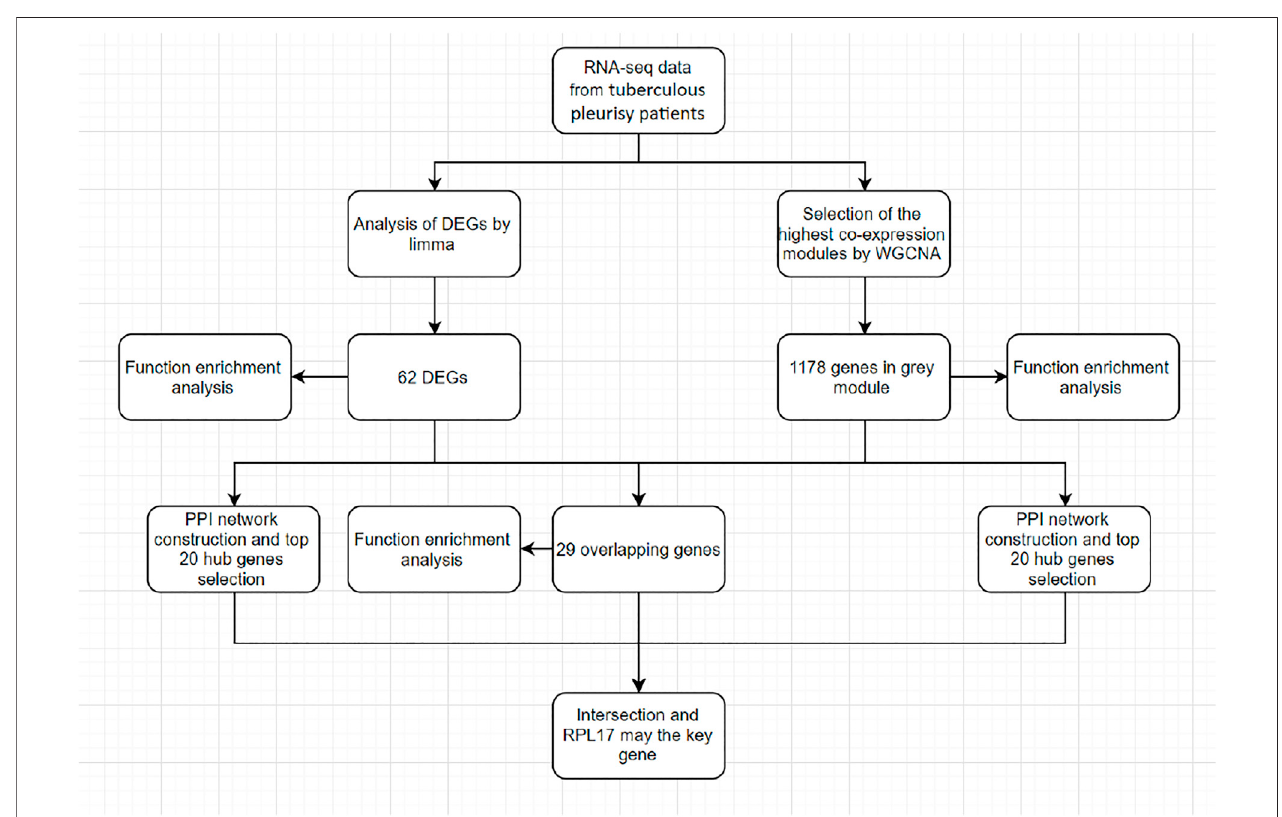
FIGURE 1 | Study design and work fl ow of this